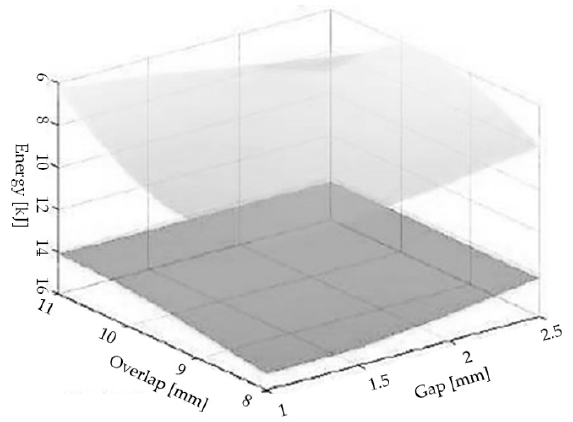
Table 4. Welding parameters applied in this study that were kept constant [17] .